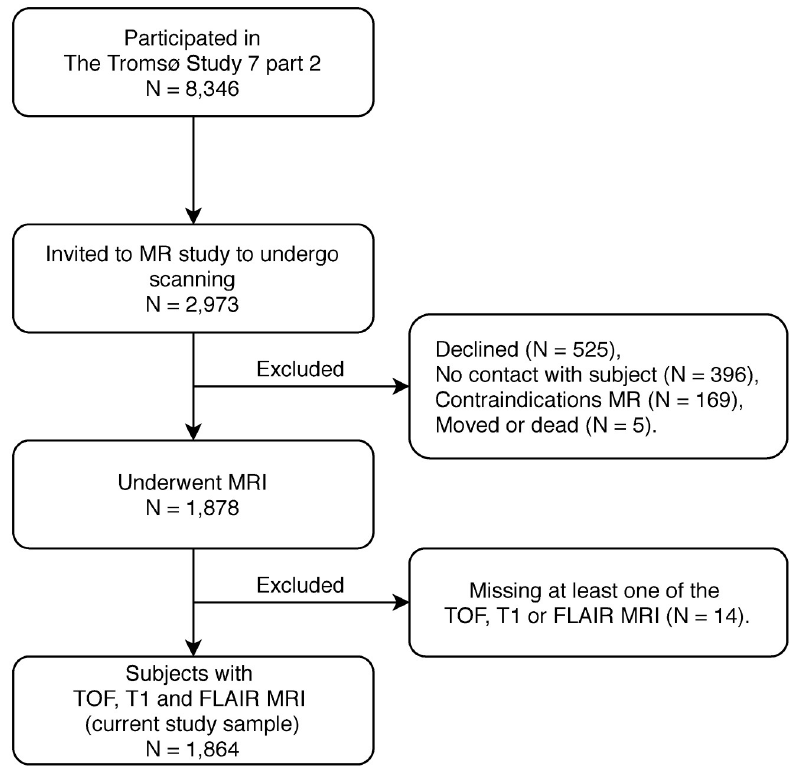
Fig 1. Flow chart of the selection of subjects from the seventh Troms ø Study to the current study. MR = Magnetic resonance, MRI = Magnetic resonance imaging, TOF = Time-of-flight angiography series, T1 = T1-weighted series, FLAIR = T2-weighted fluid-attenuated inversion recovery